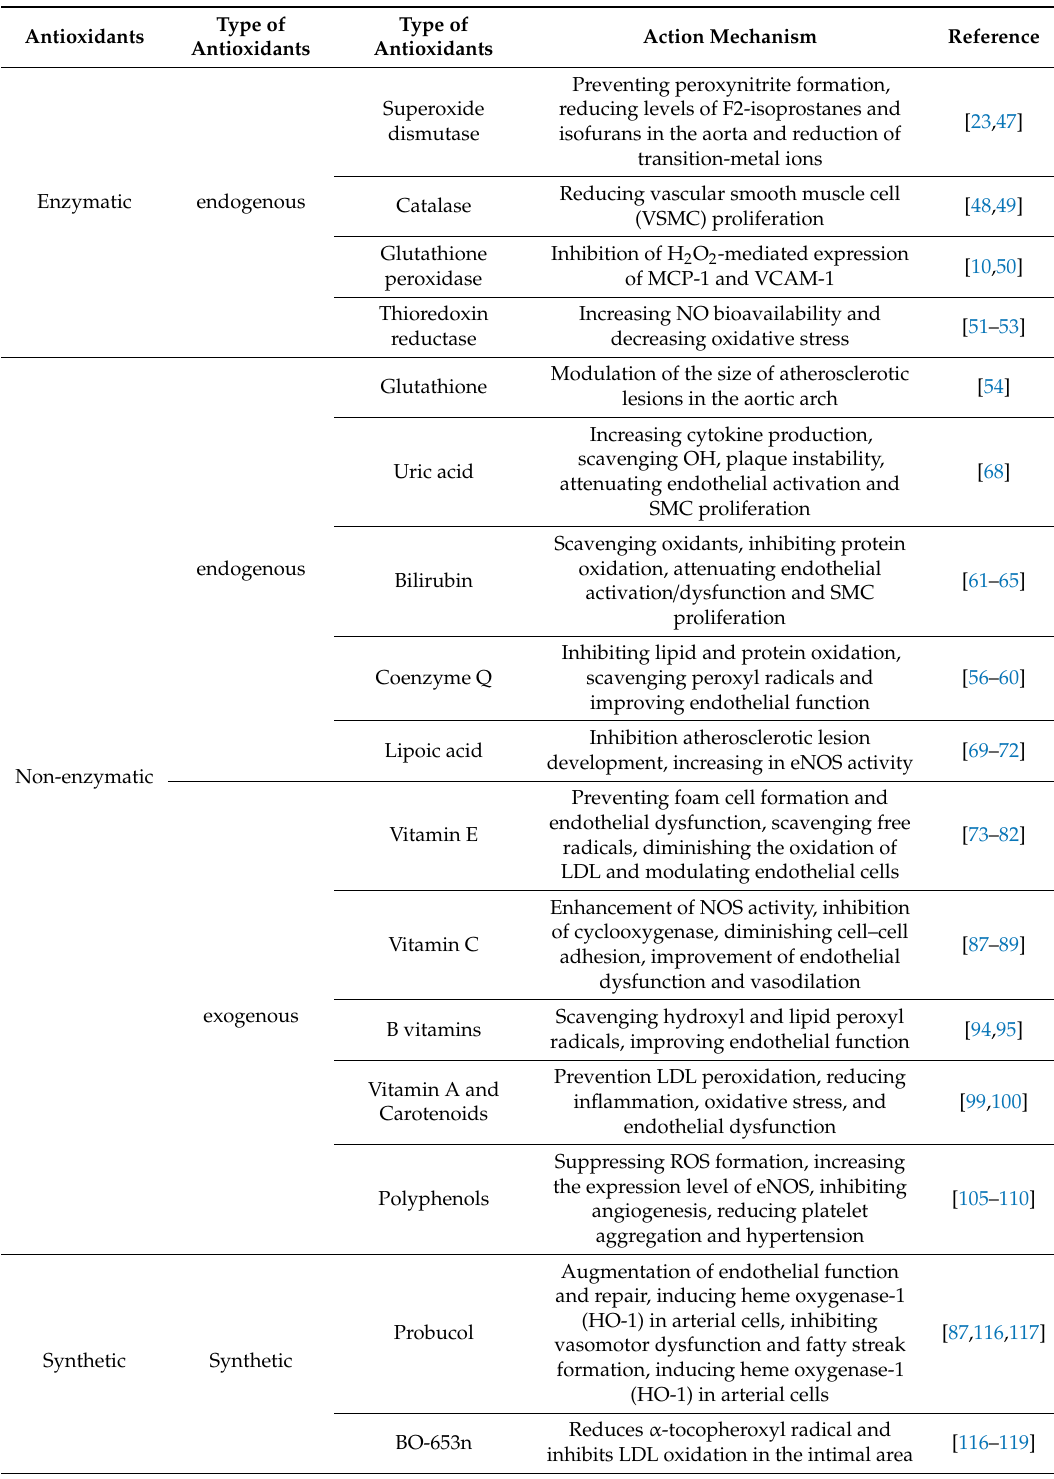
Table 1. Important enzymatic, non-enzymatic, and synthetic